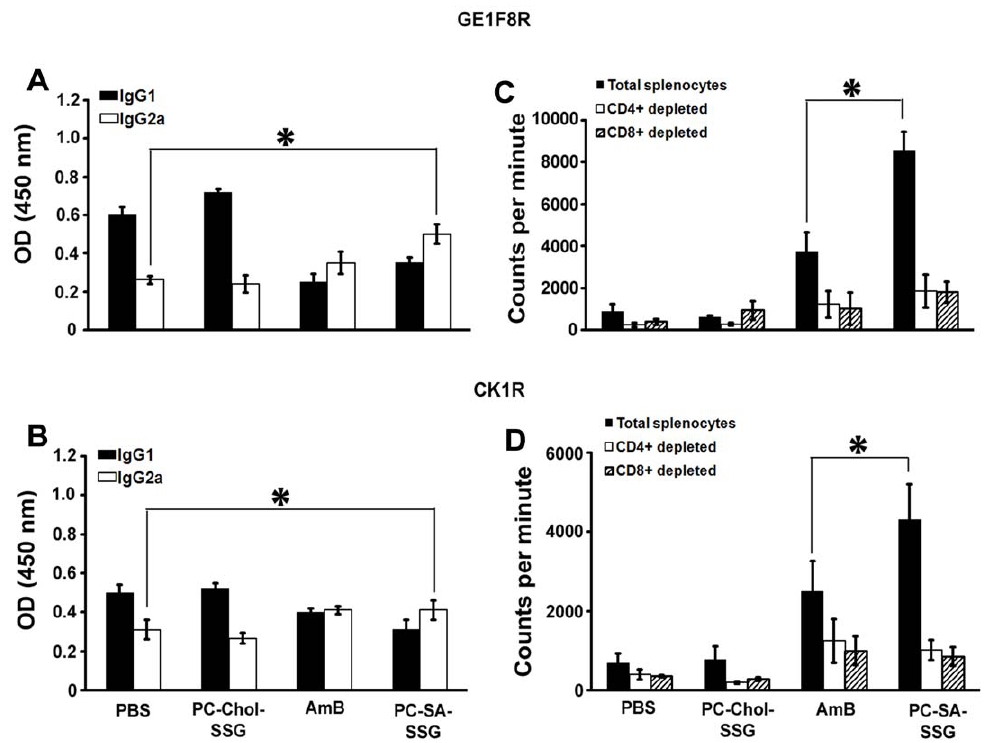
Figure 6. Humoral and antigen-specific proliferative response following treatment with PC-SA-SSG. (A, B) Sera from treated mice were analyzed individually by ELISA for detection of IgG1 and IgG2a antibodies in GE1F8R and CK1R-infected groups of mice (3-5 mice/group). The results are representative of two independent experiments and data represent mean 6 SEM. * p , 0.05 compared to PBS treatment. (C, D) Total, and CD4 + and CD8 + T cell-depleted splenocytes from treated groups were stimulated in vitro with Leishmania membrane antigen (LAg) (12.5 m g/ml). After 48 h, [ 3 H] thymidine was added and cells were harvested subsequently. Proliferative index was measured as [ 3 H] thymidine incorporation in counts per minute. Data represent mean 6 SEM (3 mice/group) in triplicates. * p , 0.05 compared to AmB